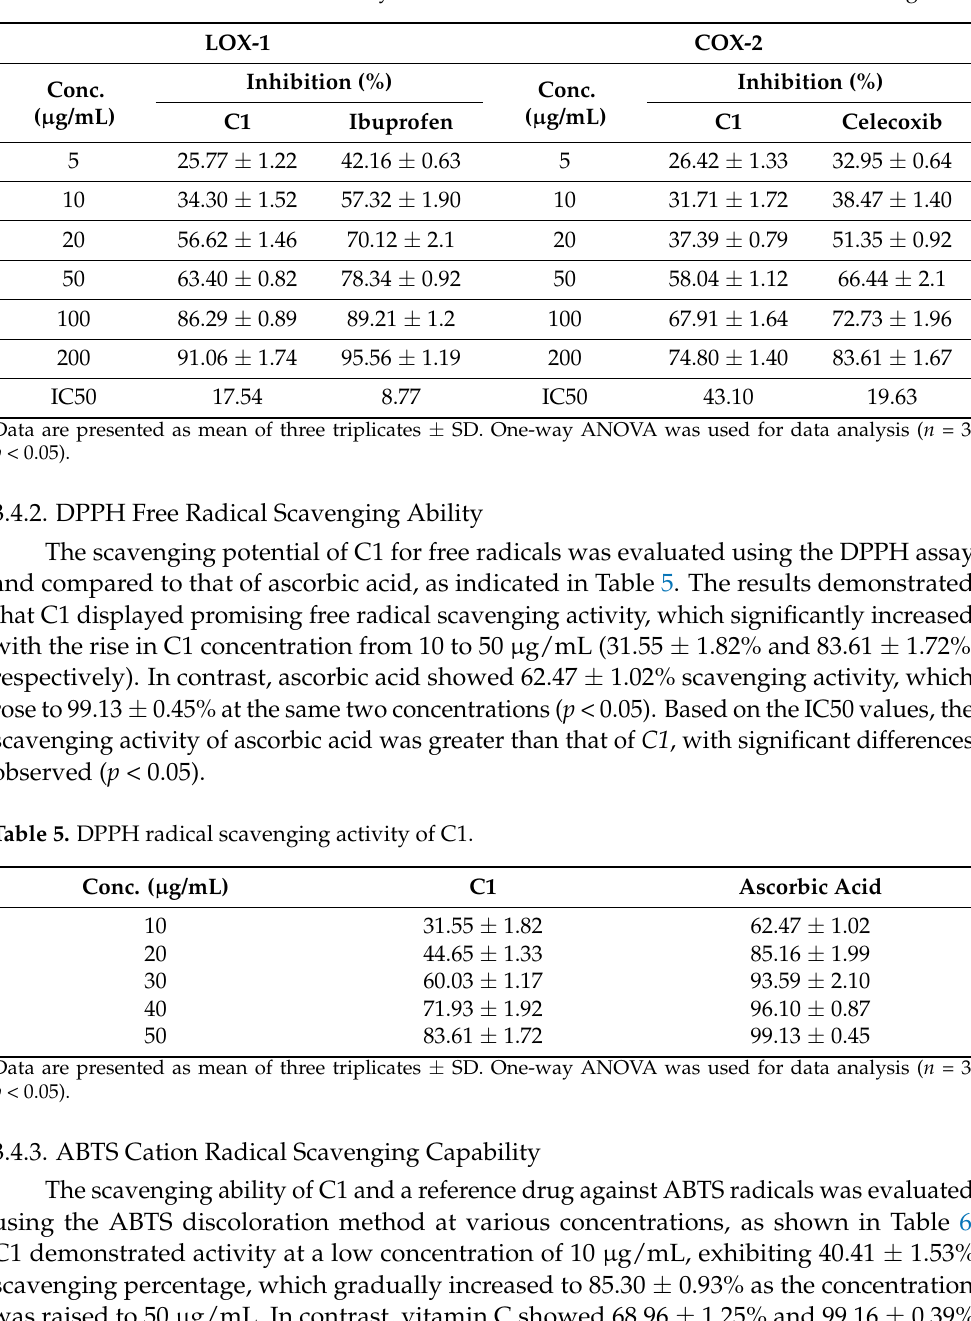
Table 4. COX-2 and LOX-1 inhibition by different concentrations of C1 and the standard drug.